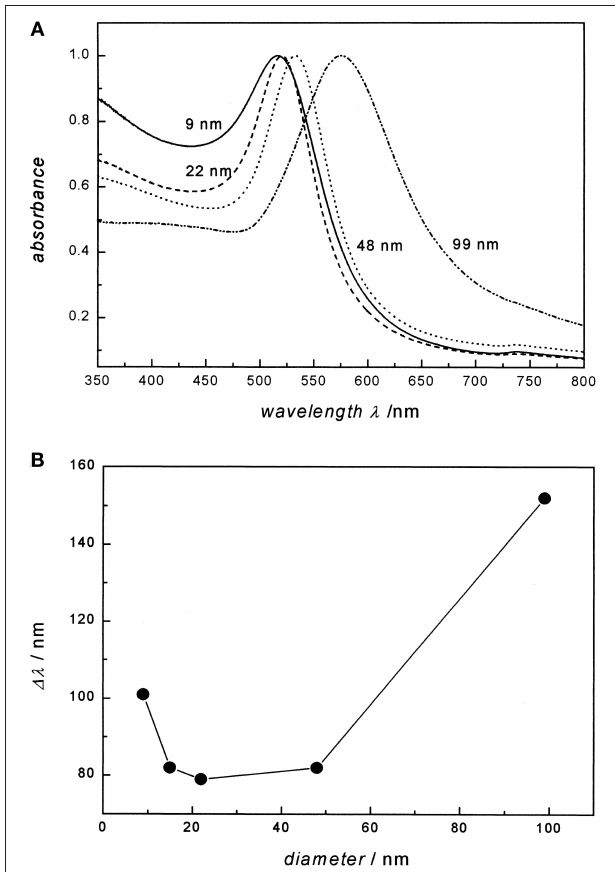
FIGURE 1 | Particle diameter of Au on the absorption spectra and the plasmon bandwidth. (A) UV/ Visual absorption spectra of 9, 22, 48, and 99nm gold nanoparticles in water. All spectra are normalized at their absorption maxima, which are 517, 521, 533, and 575nm, respectively. (B) The plasmon bandwidth 1 λ as a function of particle diameter. Re-printed with permission from American Chemistry Society Publications 1999 ( Link and El-Sayed, 1999